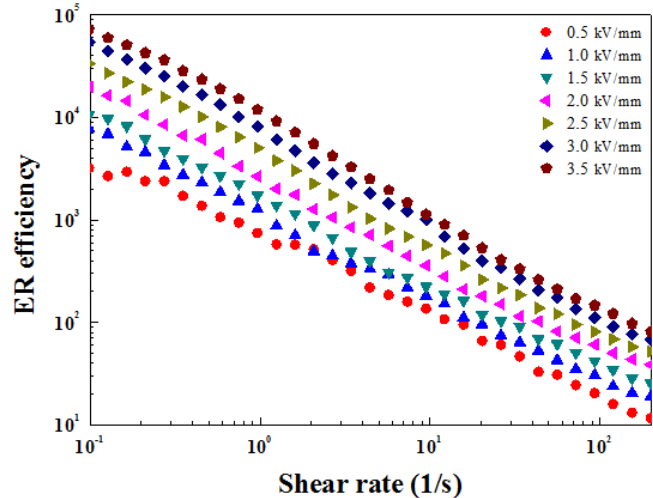
. γ under various E .